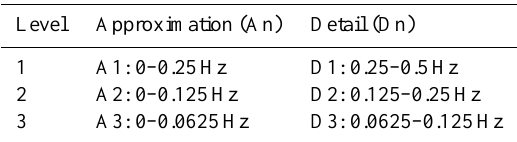
Table 3. DWT decomposition bandwidths in Hz for a